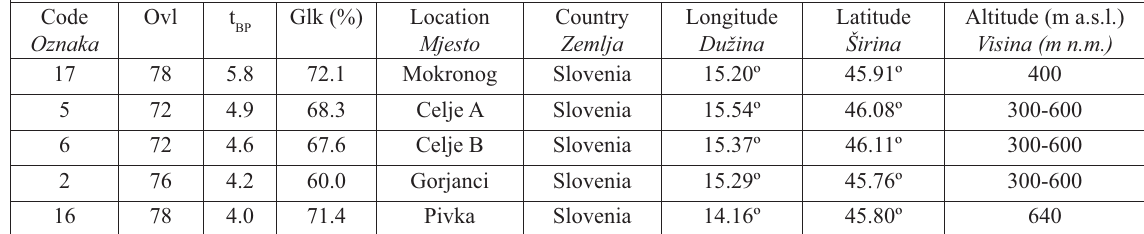
Table 3 Crossdating parameters for comparison of the residual chronology of oak from Kobiljak near Zagreb, Croatia (HR1) with local residual chronologies of beech ( Fagus sylvatica ) from various sites in Slovenia; for the location, compare Figure 6 (parameters: overlapping – Ovl, coeffi cient of agreement - Glk% and t-value – t ) BP Tablica 3 . Parametri za usporedbu rezidualne kronologije hrasta iz Kobiljaka pokraj Zagreba, Hrvatska (HR1) s lokalnim rezidualnim kronologijama bukve ( Fagus sylvatica ) iz različitih staništa u Sloveniji; lokacije usporediti sa slikom 6. (Ovl